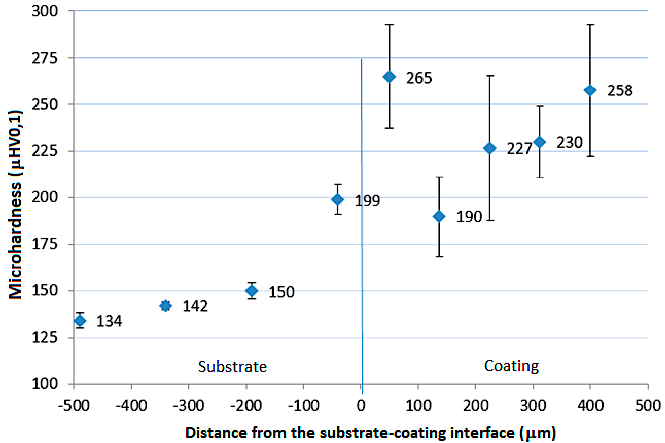
Figure 5. Distribution of microhardness in substrate material and the arc sprayed Fe-Al coating.